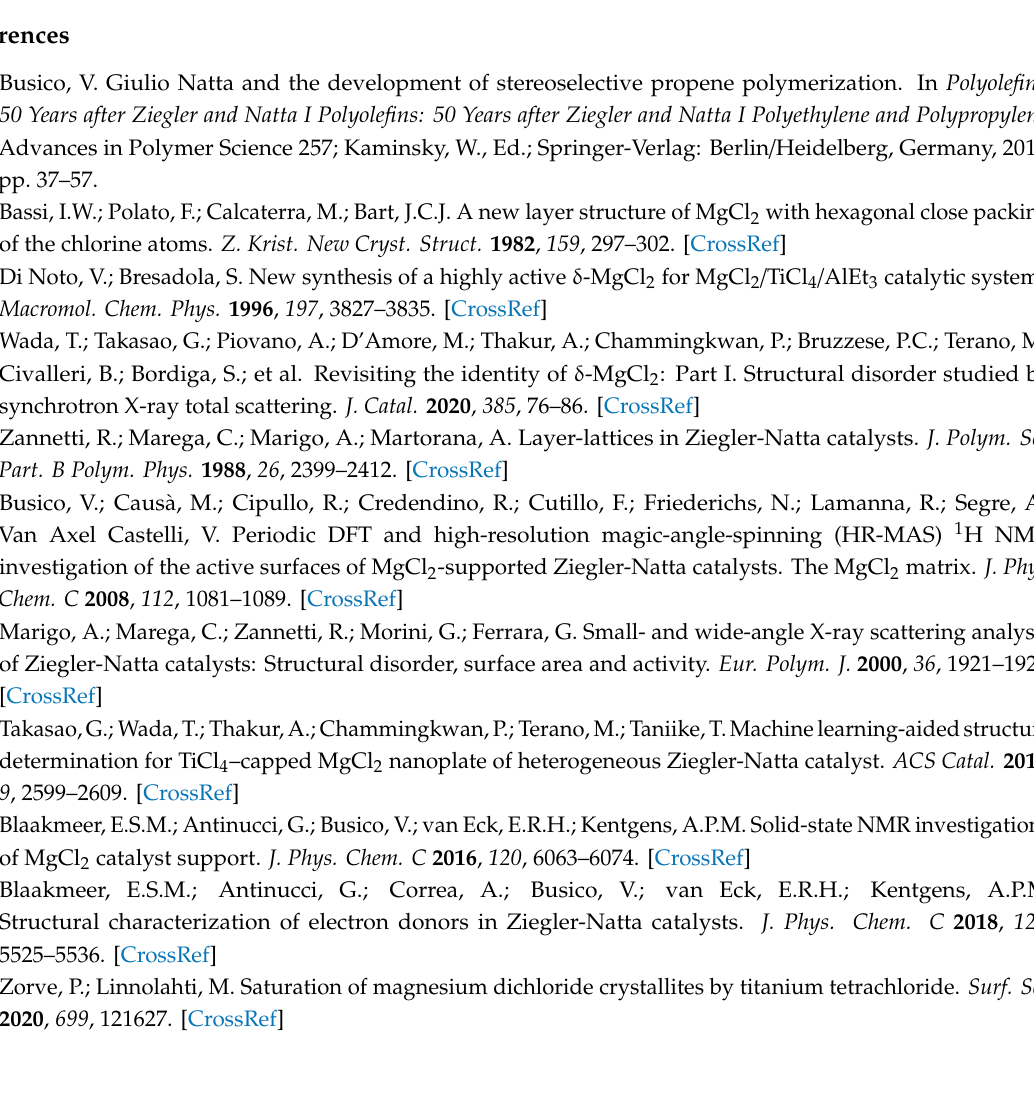
Figure S1: Typical PXRD fitting result, Figure S2: Typical PDF fitting result, Table S1: Results of PDF fitting with